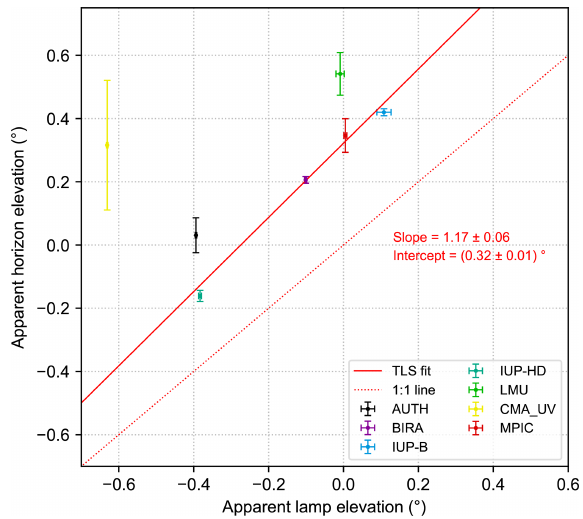
Figure 19. Correlation between retrieved horizon (at 340nm) and lamp elevations for all participating instruments that reported results for both methods. The error bars indicate the standard errors of the mean lamp and horizon elevations. Further, the result of a total least squares (TLS) fit and the 1 : 1 line are shown.